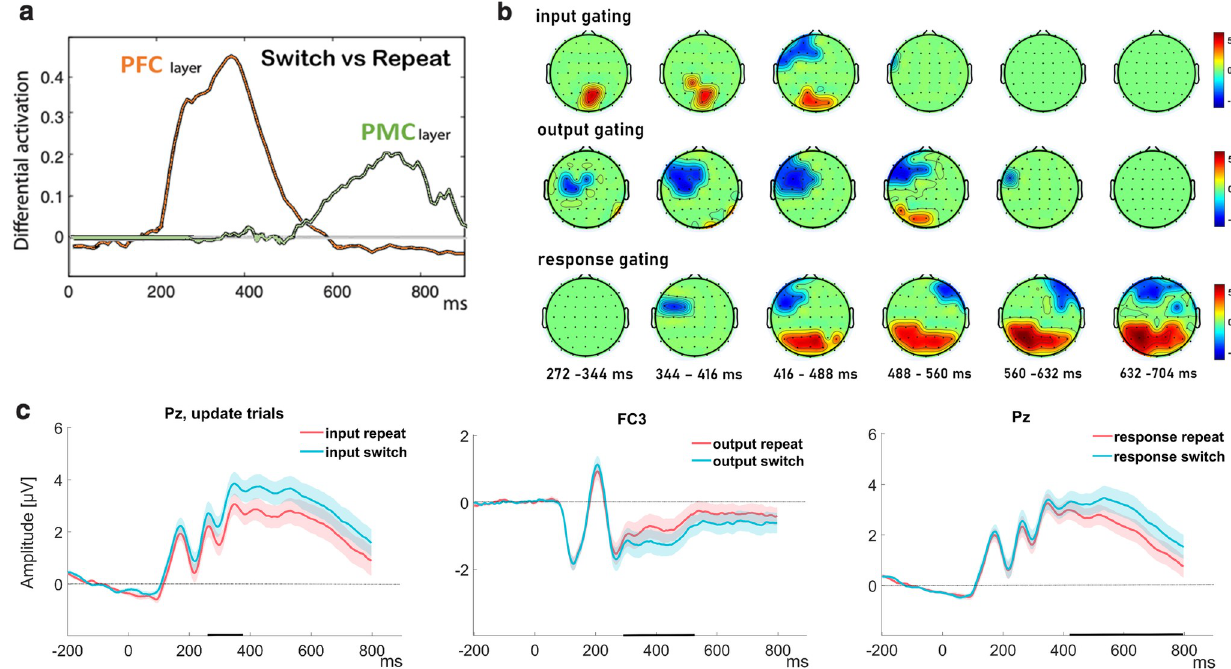
Fig 4. (a) Summed activation over units in PFC-BG neural network, showing impact of gate switch vs repeat early in PFC and later in motor cortex (adapted from [62]). (b-c) Current study. (b) Scalp map topography for the predictors that survived permutation correction for the three gating types (input in updating trials, output, response in three rows from top to bottom). The color in the scalp map represent the t-value of the average regression weights in each electrode at the time range indicated above each scalp map. Input, output and response gating signatures evolve sequentially in time, but with clear temporal overlap. (c) Grand ERP plots at representative electrodes from the significant univariate patterns show significant and dissociable effects for switching during input, output and response gating. The shaded error bars represent standard error of the mean (SEM) and the black markers on the x-axis reflect the time points where the difference between switch and repeat was